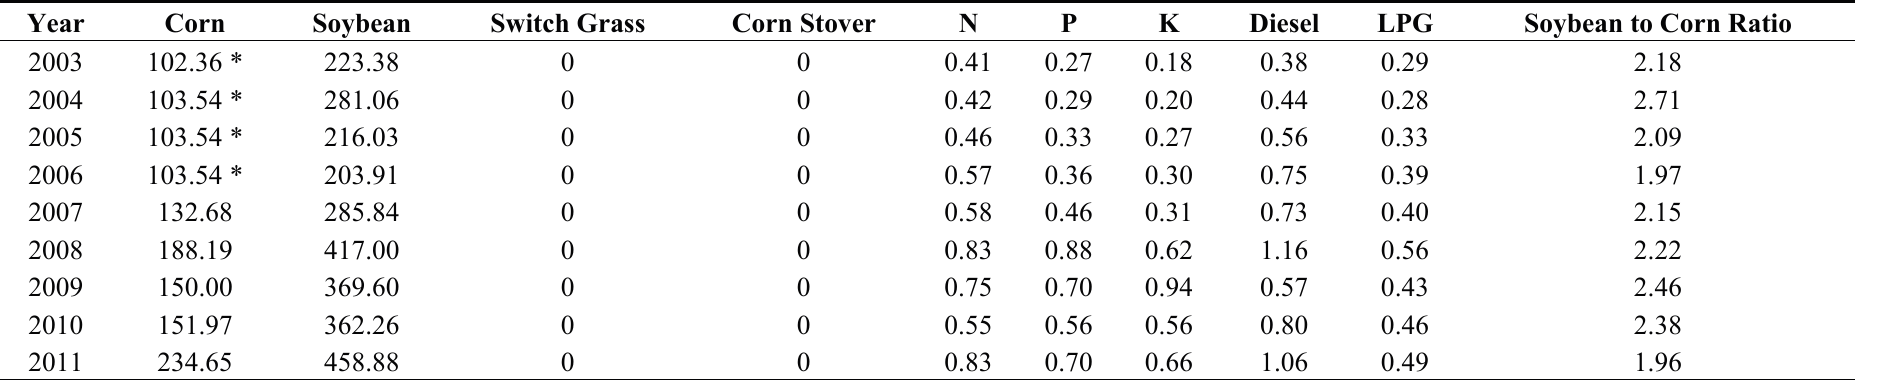
Table 2. Historical market prices (corn, soybean switchgrass and corn stover prices in $/metric ton, fertilizer prices in $/kg, fuel prices in $/liter, soybean to corn price ratio is dimensionless).